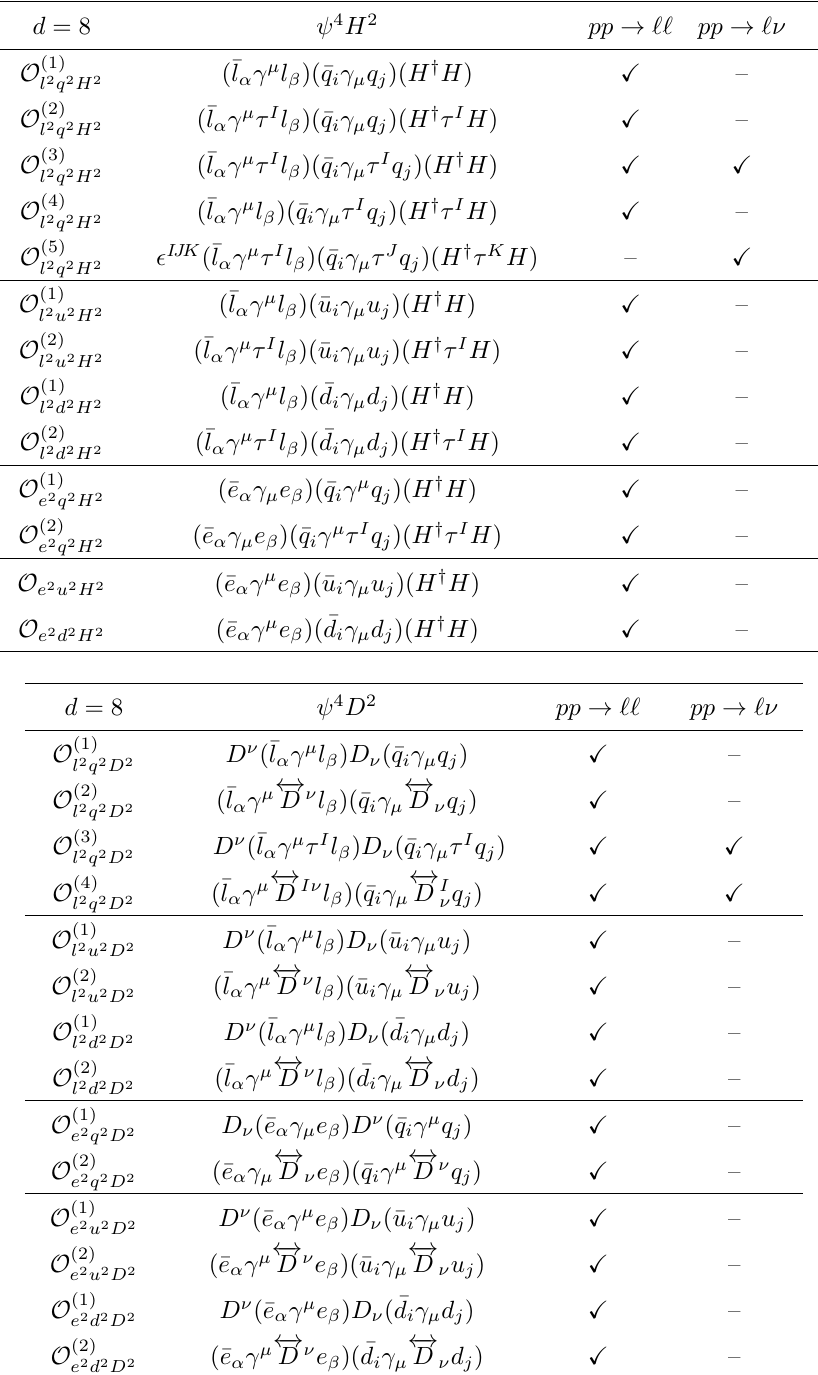
Table 7. SMEFT d = 8 four-fermion operators that contribute to the processes pp → ‘‘ and pp → ‘ν . We use the basis defined in ref. [70], where we relabeled the operators O ( k ) to O ( k ) and O ( k ) , respectively, to conveniently have lepton- before quark-flavor O ( k ) q 2 e 2 D 2 e 2 q 2 H 2 e 2 q 2 D 2